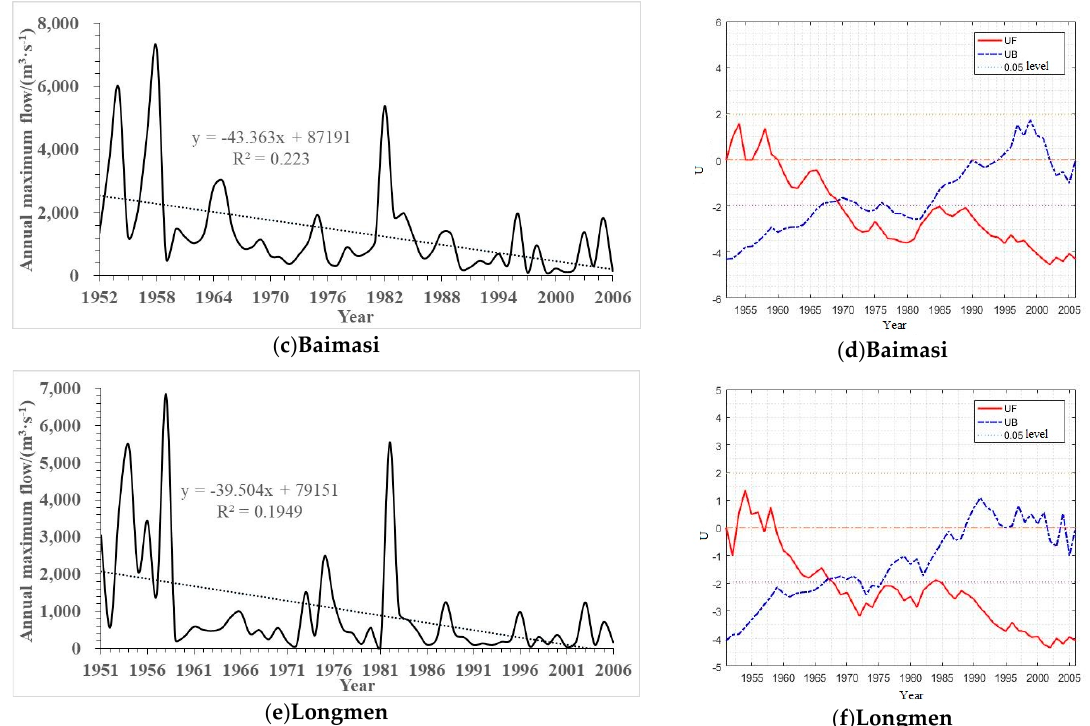
Figure 2. Trend of annual maximum discharge sequence in Heishiguan, Baimasi and Longmen hydrological station (( a , c , e ) trend test, ( b , d , f ) Mann–Kendall test). Table 1. Hurst index and